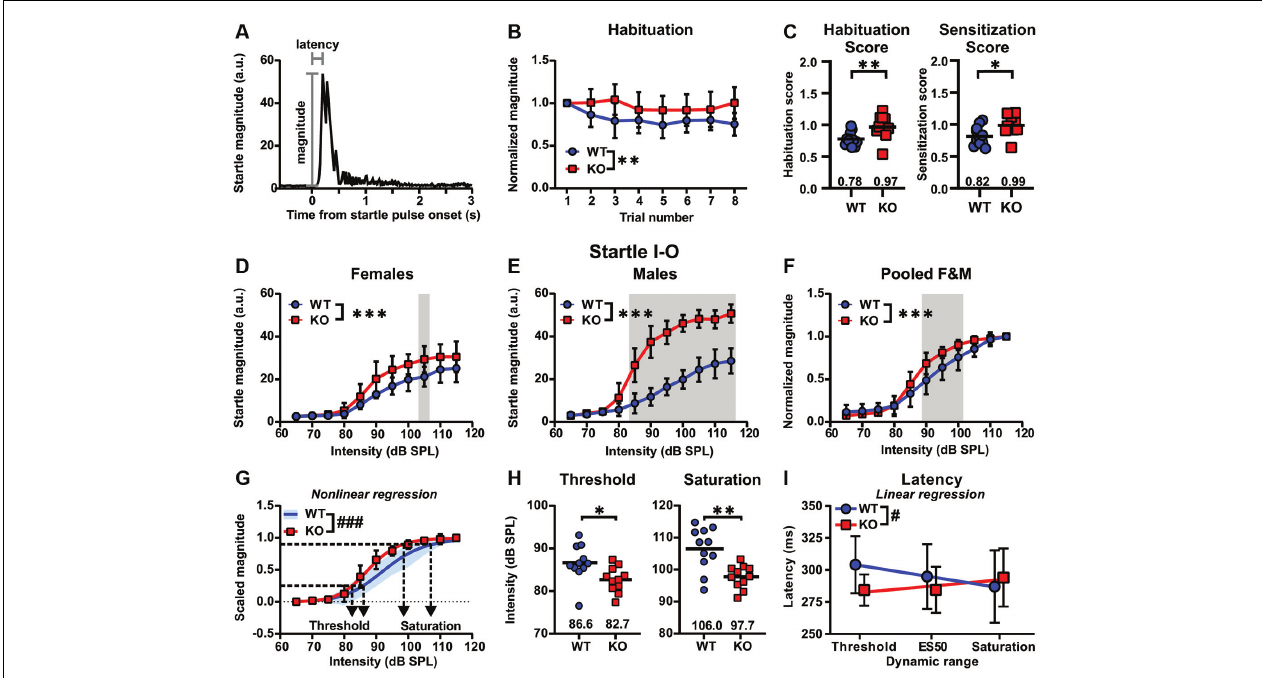
FIGURE 3 | Impaired short-term habituation and increased acoustic reactivity in Cntnap2 KO compared with wildtype (WT) rats. (A) Schematic raw acoustic startle trace to a 115 dB SPL startle pulse. ASR peak magnitude and latency is determined within the recording window of 500 ms from startle pulse onset. (B,C) Sensory filtering as measured by short-term habituation is perturbed in Cntnap2 KO rats. (B) Mean ± standard deviation (SD) startle response magnitudes across eight subsequent trials normalized to the first trial in Cntnap2 WT and KO rats. Values < 1 indicate habituation of the startle response. Cntnap2 KO rats showed less declined startle responses than WT rats, indicating perturbed habituation, in particular at trial number eight ( Cntnap2 WT: n = 11, Cntnap2 KO: n = 11, two-way repeated measures (RM) ANOVA, trial × genotype p = 0.0225, F (7,140) = 2.425, trial p = 0.0012, F (4.714,94.28) = 4.528, genotype p = 0.0053, F (1,20) = 9.792, Sidak’s multiple comparisons test, p = 0.0151). (C) Left : Individual habituation scores calculated from the average of the last two trials divided by that of the first trial (WT: blue circles, KO: red squares, mean: horizontal black line). Values < 1 indicate habituation of the startle response. Cntnap2 KO rats had significantly greater habituation scores compared with WT rats (two-sided student’s t -test p = 0.0082). Right : Individual sensitization scores calculated from the average of trials 2–4 divided by that of the first trial (WT: blue circles, KO: red squares, mean: horizontal black line). Cntnap2 KO rats showed greater sensitization scores than WT rats (two-sided student’s t -test p = 0.0150). (D–F) Mean ± SD startle responses in female (F) (D) , male (M) (E) , and pooled male and female (C) Cntnap2 WT (blue circles) and KO (red squares) rats to startle pulses with sound intensities from 65 to 115 dB SPL in 5 dB steps. (D) Acoustic startle magnitudes were significantly increased in female Cntnap2 KO (WT: n = 6, KO: n = 6, two-way ANOVA, intensity × genotype p = 0.1598, F (10,110) = 1.471, intensity p < 0.0001, F (10,110) = 61.70, genotype p < 0.0001, F (1,110) = 28.83) and (E) male Cntnap2 KO rats (WT: n = 5, KO: n = 5, two-way ANOVA, intensity × genotype p < 0.0001, F (10,88) = 14.97, intensity p < 0.0001, F (10,88) = 100.1, genotype p < 0.0001, F (1,88) = 301.7) compared with WT littermates when collapsing over intensities, indicated by a leftward shift of the I-O ASR function. In particular, startle magnitudes were elevated in female Cntnap2 KO at 105 dB SPL (Sidak’s multiple comparisons test, p = 0.0303) and in male Cntnap2 KO rats at 85–115 dB SPL (Sidak’s multiple comparisons test, all p < 0.0001). (F) Normalized ASR I-O functions pooled for male and female Cntnap2 WT and KO rats were significantly different ( Cntnap2 WT: n = 11, Cntnap2 KO: n = 11, two-way ANOVA intensity × genotype p < 0.0001, F (10,220) = 4.750, intensity p < 0.0001, F (10,220) = 313.5, genotype p < 0.0001, F (1,220) = 20.63). Normalized startle magnitudes in Cntnap2 KO rats were particularly increased in comparison to Cntnap2 WT rats at 90–100 dB SPL (Sidak’s multiple comparisons test, 90 dB SPL: p < 0.0001, 95 dB SPL: p = 0.0005, 100 dB SPL: p = 0.0069). (G) Sigmoidal curves (lines) fitted to the startle magnitudes scaled between 0 and 1 were significantly different in Cntnap2 WT (SD, blue area) and Cntnap2 KO rats (mean ± SD, red squares and error bars; p < 0.0001, curve fit values see Table 1 ). Dotted horizontal line at 0.25 determined as ASR threshold and at 0.9 as ASR saturation. (H) Individual ASR thresholds ( Left ) and saturation ( Right ) extracted from individual sigmoidal curve fits were significantly lower in Cntnap2 KO rats (blue squares, horizontal black lines: mean) compared with WT controls (red circles, horizontal black lines: mean; two-sided student’s t -test, threshold: p = 0.0210, saturation: p = 0.0012). (I) Linear regression of ASR peak latencies across the dynamic range of Cntnap2 WT (mean ± SD, blue circles and error bars, Y = − 8.537 * X + 312.4, r 2 = 0.9979, blue line) and KO rats (mean ± SD, red squares and error bars, KO: Y = 4.910 * X + 277.8, r 2 = 0.7576, red line). The slopes of the regression lines were significantly different ( p = 0.0408). ES50, acoustic startle pulse intensity that gives a startle magnitude at 50%. ∗ p < 0.05; ∗∗ p < 0.01; ∗∗∗ p < 0.001; # p < 0.05 (comparison of regression lines); ### p < 0.001 (comparison of regression lines).